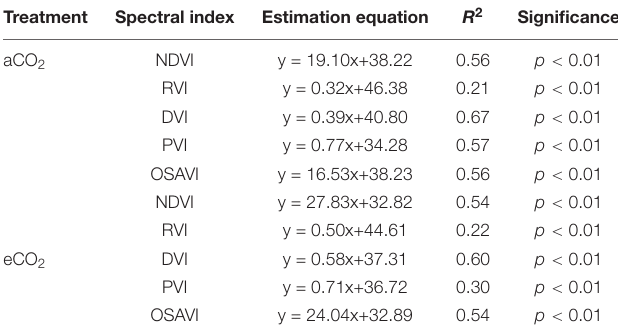
( Table 3 ). The DVI based estimation models was established using half of the measured data ( Figure 7 ) and validated using the rest of the sampling data ( Figure 8 ). The R 2